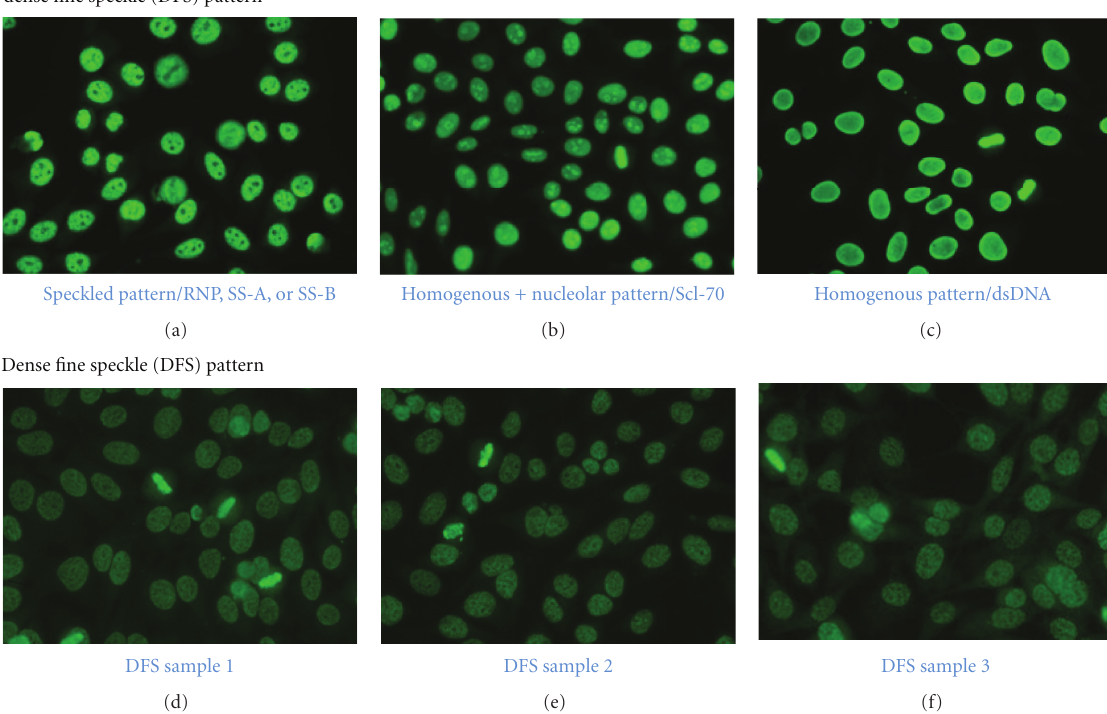
Figure 1: Identification of the dense fine speckled pattern is not always an easy task. The DFS pattern has to be di ff erentiated from (a) speckled patterns generated by autoantibodies against RNP, Ro60 and SS-B (La), (b) from homogeneous patterns generated by anti-Scl-70 antibodies, and from (c) homogenous patterns generated by anti-dsDNA antibodies. DFS patterns generated by three di ff erent samples are shown in (d)–(f). Samples (d) and (e) are monospecific anti-DFS70 samples, and sample (f) also contains low titers of antibodies against extractable nuclear antigens